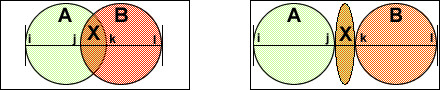
The rules for setting the intervals for ancestral character states are shown diagramatically. If an intersection exists among values at connected nodes, it is the minimum evolution range. If not, the range is the distance between the closest possible values from connected nodes.